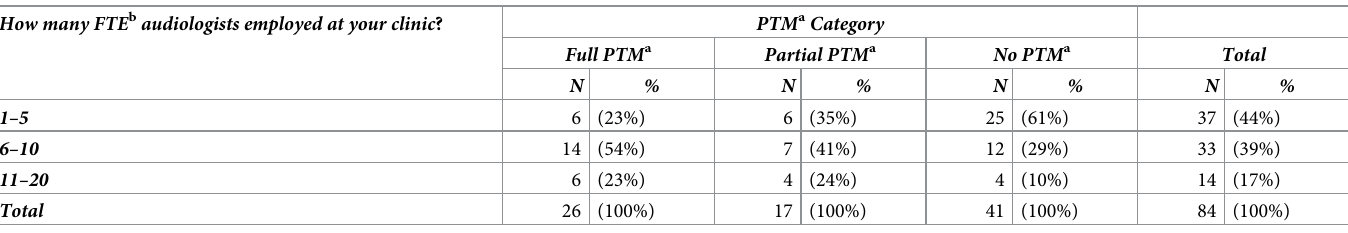
Table 4. PTM category by number of full time equivalent (FTE)